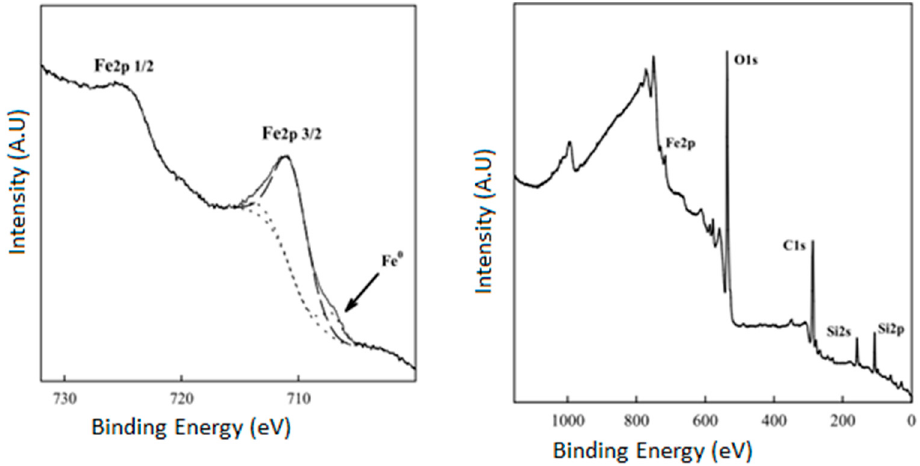
Figure 3. XPS spectra of Fe2p ( left panel ) and survey ( right panel ) of FeNP@SBA-15.